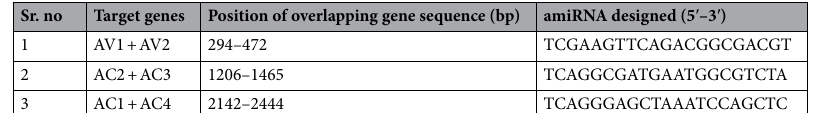
Table 1. Details of amiRNAs designed against the genes of